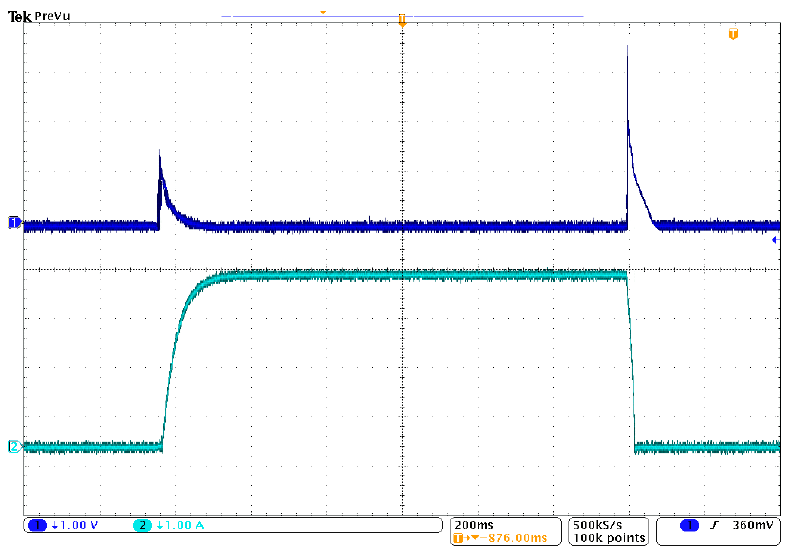
Figure 15. Oscillograms of the voltage at the output of a two ‐ port network and the current at the input with rectangular ‐ pulse forcing.